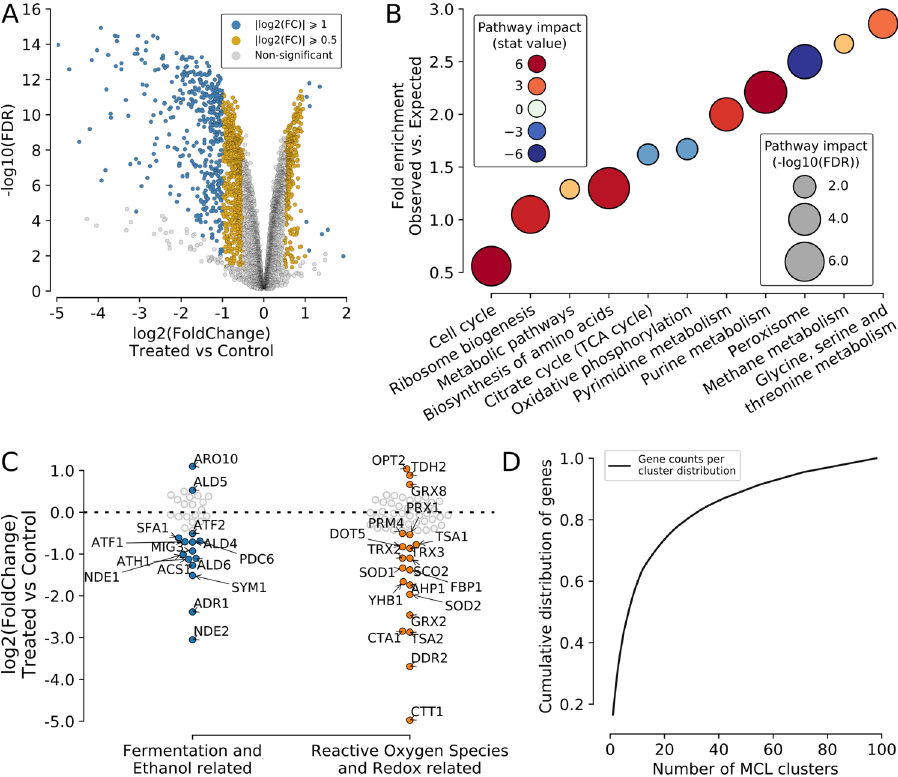
Figure 2. Differentially expressed genes under p -coumaric stress are skewed towards downregulation and can be grouped into functional clusters. ( A ) Volcano plot showing the relation between log2(Fold Change) (X-axis) and − log10(FDR) (Y-axis) for differentially expressed genes (DEGs in blue and gold) after pCA treatment. ( B ) Point plot showing the predicted perturbations in KEGG pathways (X-axis) based on RNASeq data. The Y-axis shows the fold-enrichment score identified for each pathway of DEGs; the size of the point shows the significant value of the prediction (in − log10(FDR) scale), and the color represents the direction of perturbation: downregulated (brown) or upregulated (blue). ( C ) Swarmplot showing the log2(FoldChange) profile (Y-axis) of the 13 DEGs associated with fermentation and/or ethanol (blue) and the 17 DEGs associated with reactive oxygen species response and redox processes (orange). ( D ) Cumulative distribution function (CDF) plot showing the percentage of DEGs (Y-axis) that are in clusters (X-axis), starting from the biggest clusters (in the number of